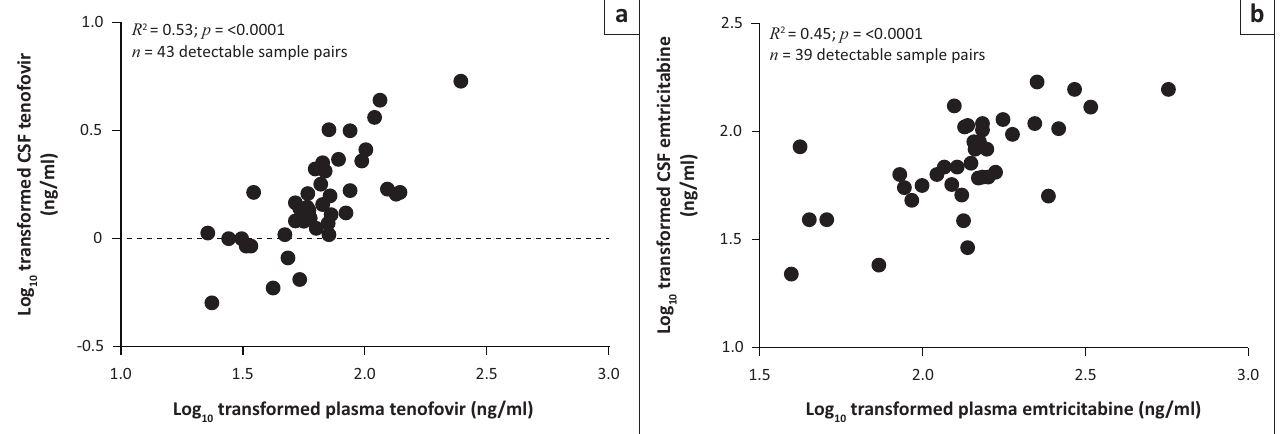
Figure 1-A1: Pearson correlation plots for log -transformed plasma and cerebrospinal fluid (CSF) concentrations emtricitabine and tenofovir. Panel A : Relationship 10 between CSF and plasma tenofovir concentrations. Panel B : Relationship between CSF and plasma emtricitabine concentrations. All concentrations are log